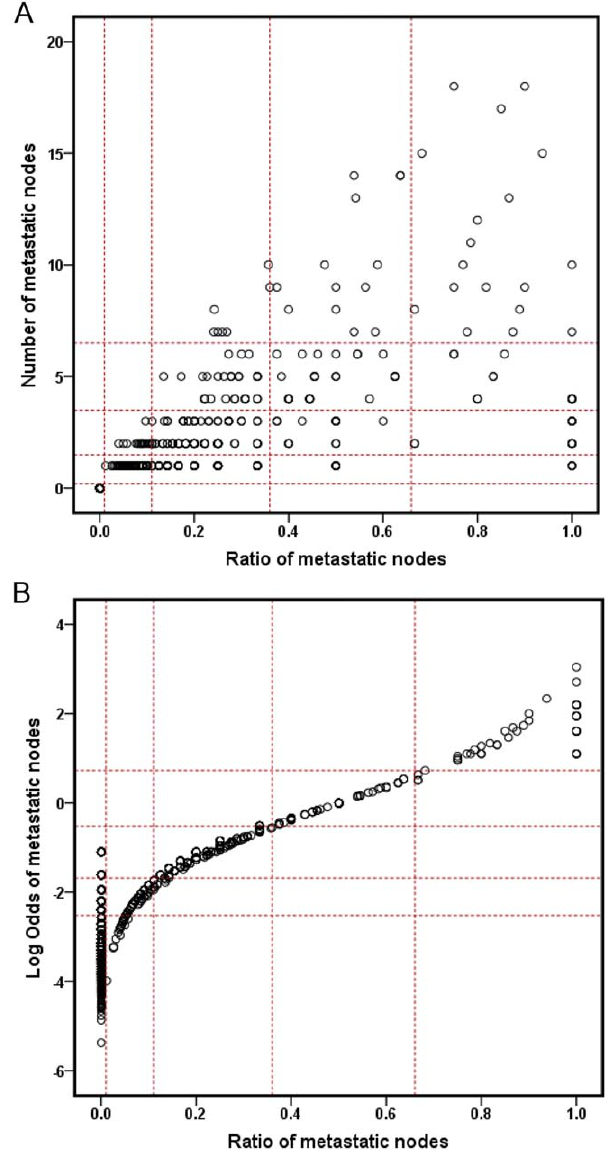
Figure 3. The distribution of the pN & LNR(A) and LODDS &